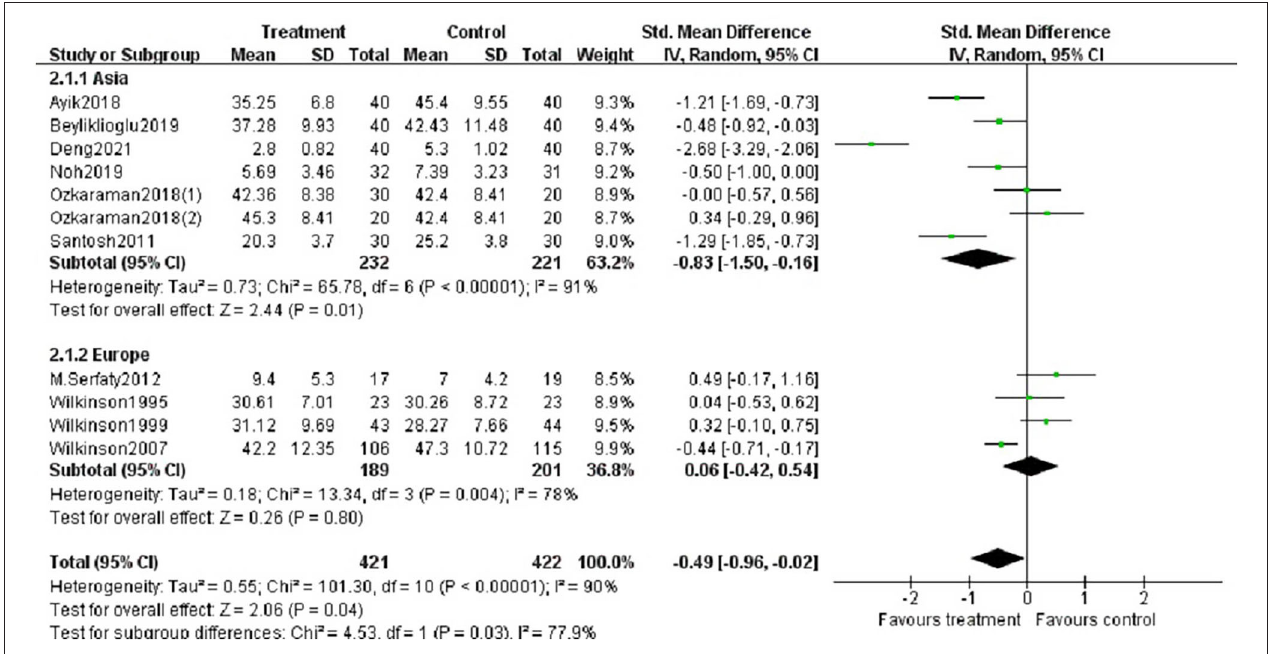
FIGURE 6 | Subgroup analysis according to the study location.